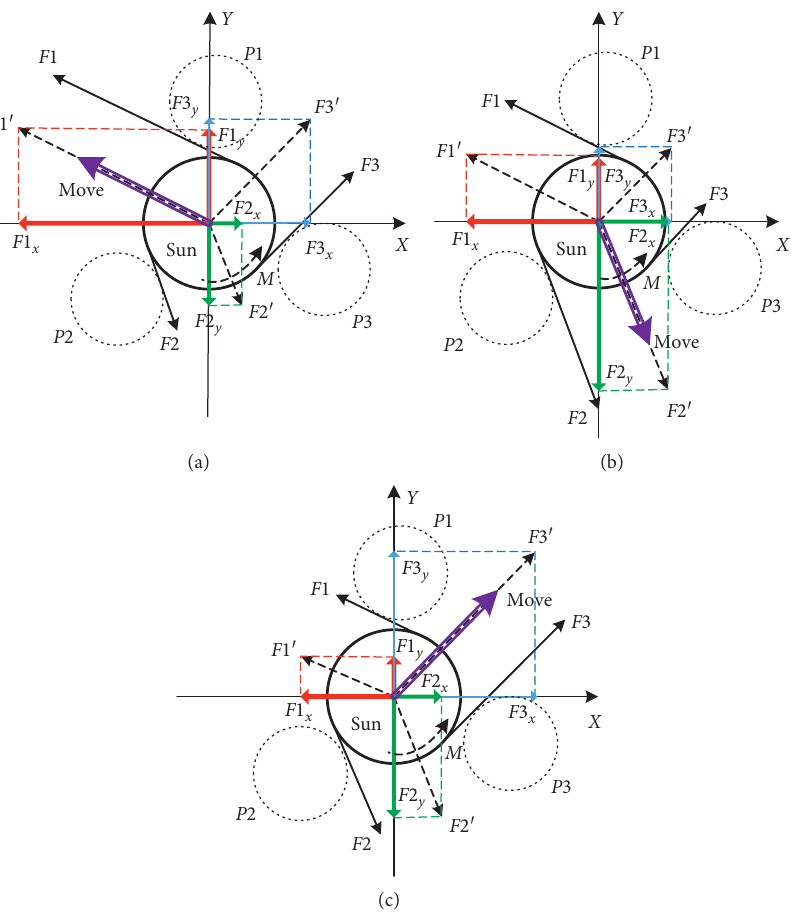
Figure 9: Diagram of meshing force on the sun gear.